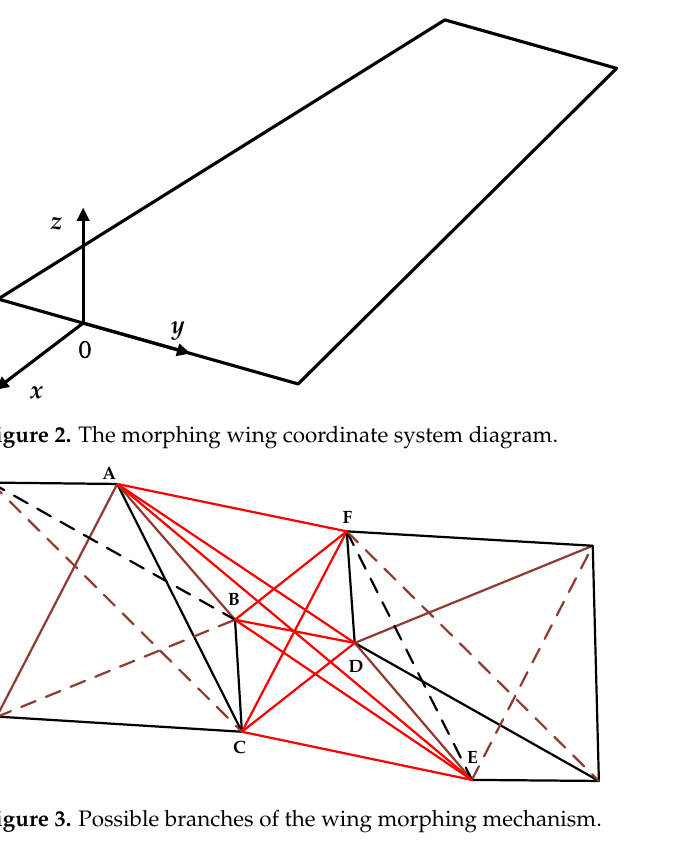
Figure 3. Possible branches of the wing morphing mechanism.